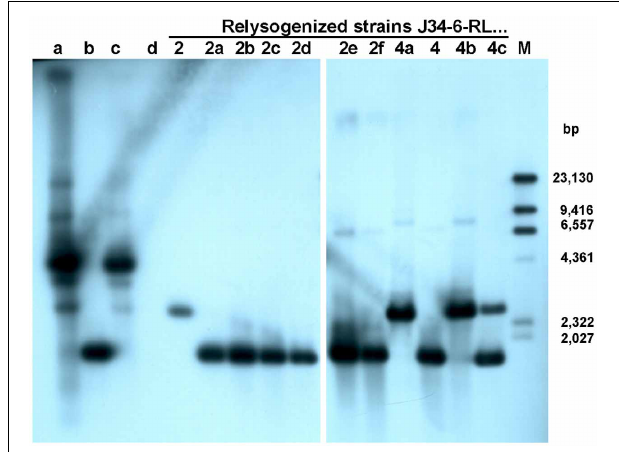
FIGURE 5 | Southern blot with DIG-labeled 1kb probe of HindIII-cleaved phage and chromosomal DNA of eleven S. thermophilus strains relysogenized with TP-J34. Lane a: TP-J34; lane b: TP-J34L; lane c: J34; lane d: J34-6 (no prophage, negative control); lane M: DIG-labeled, HindIII-cleaved λ DNA. Other lanes (from left to right): J34-RL2; J34-6-RL2a; J34-6-RL2b; J34-6-RL2c; J34-6-RL2d; J34-6-RL2e; J34-6-RL2f; J34-6-RL4a; J34-6-RL4; J34-6-RL4b; J34-6-RL4c. The sizes of the λ DNA bands are indicated in the right margin.